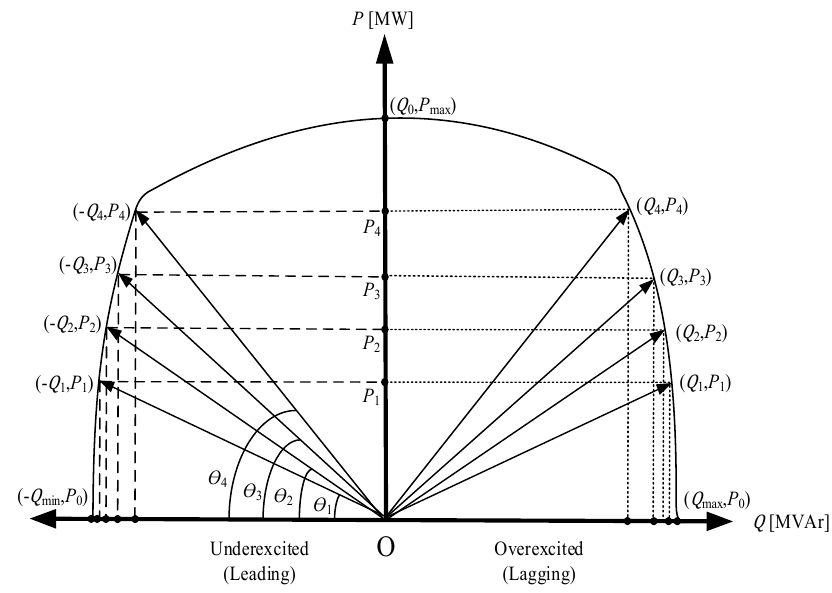
Figure 10. How to plot the capability curve.